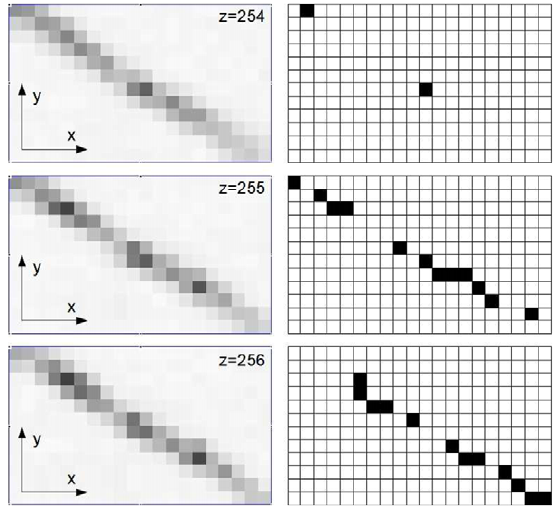
Figure 8. Automatic adaption of template size. After subtracting the mean intensity from each template pixel, the borders of the pattern can be identified by their negative values. Thus, the template can be adjusted to an optimal size. Due to this feature, the algorithm is scale invariant.